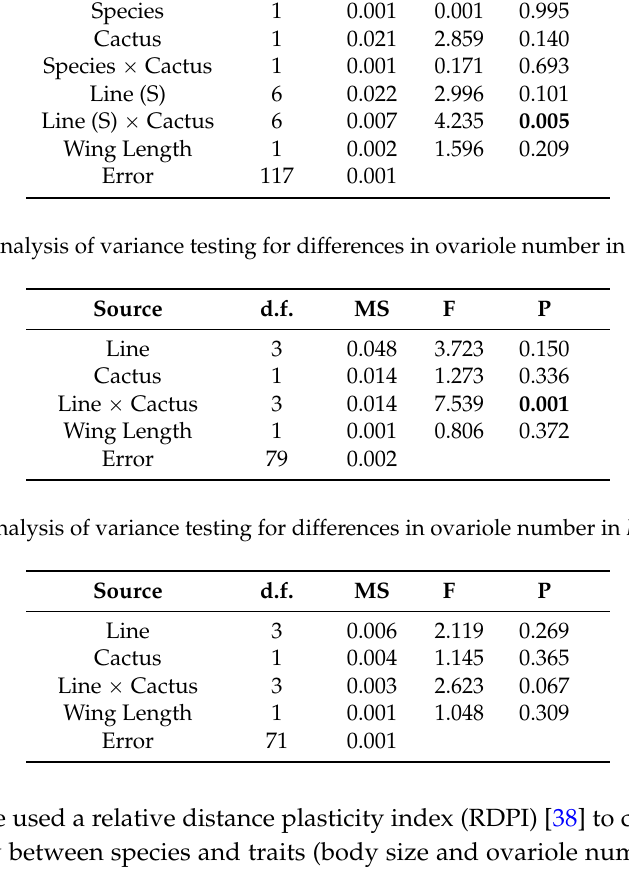
Table 1. Analysis of variance testing for differences in ovariole number for both species. Source